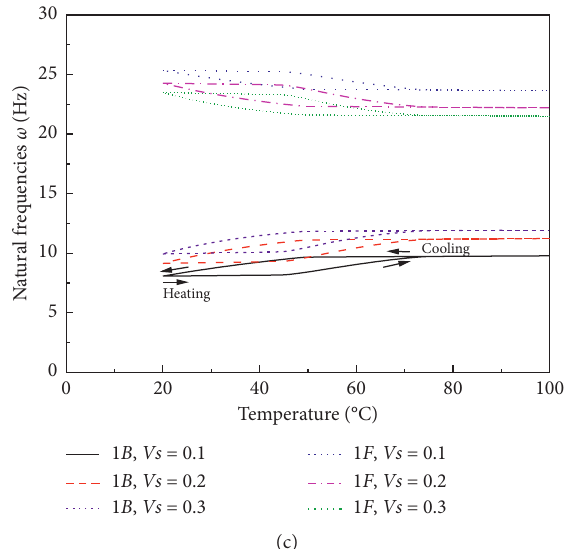
Figure 7: The first natural frequencies versus temperature of the tapered composite rotating shaft for different SMA fiber fractions � 0 . 005): (a) C-C; (b) S-S; (c) ( σ � 0 . 5 , Ω � 1000rpm , θ � 30 ° , ε 0